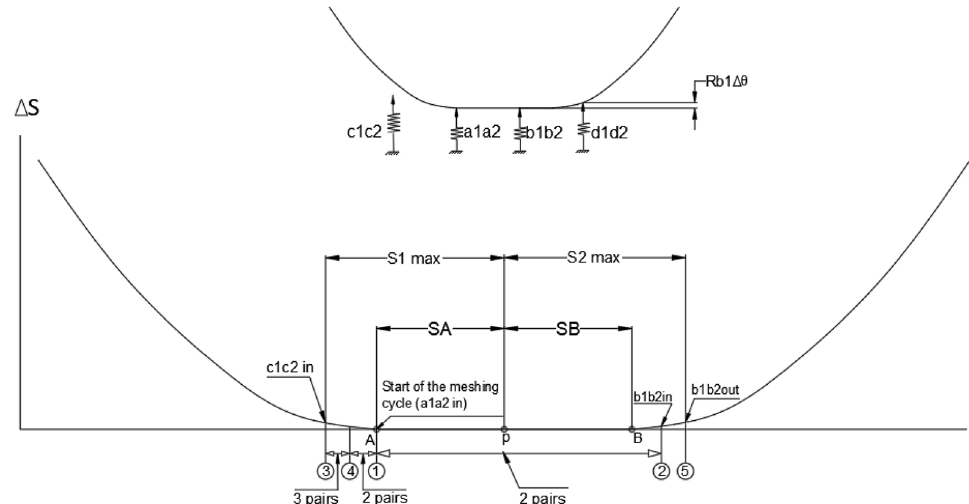
Fig. 8. Behavior of a Nylon 66 pair of plastic gears with 25 teeth each with an